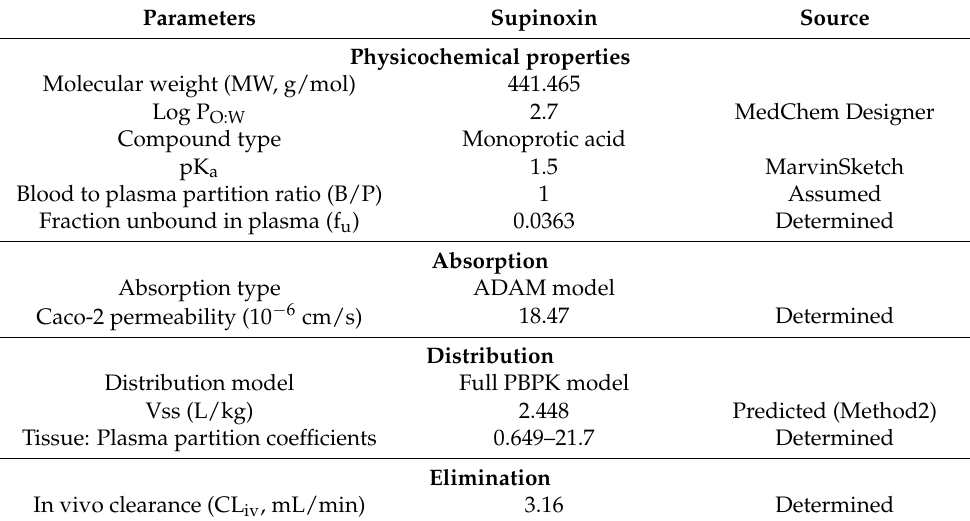
Table 5. Summary of input parameters for supinoxin in the PBPK